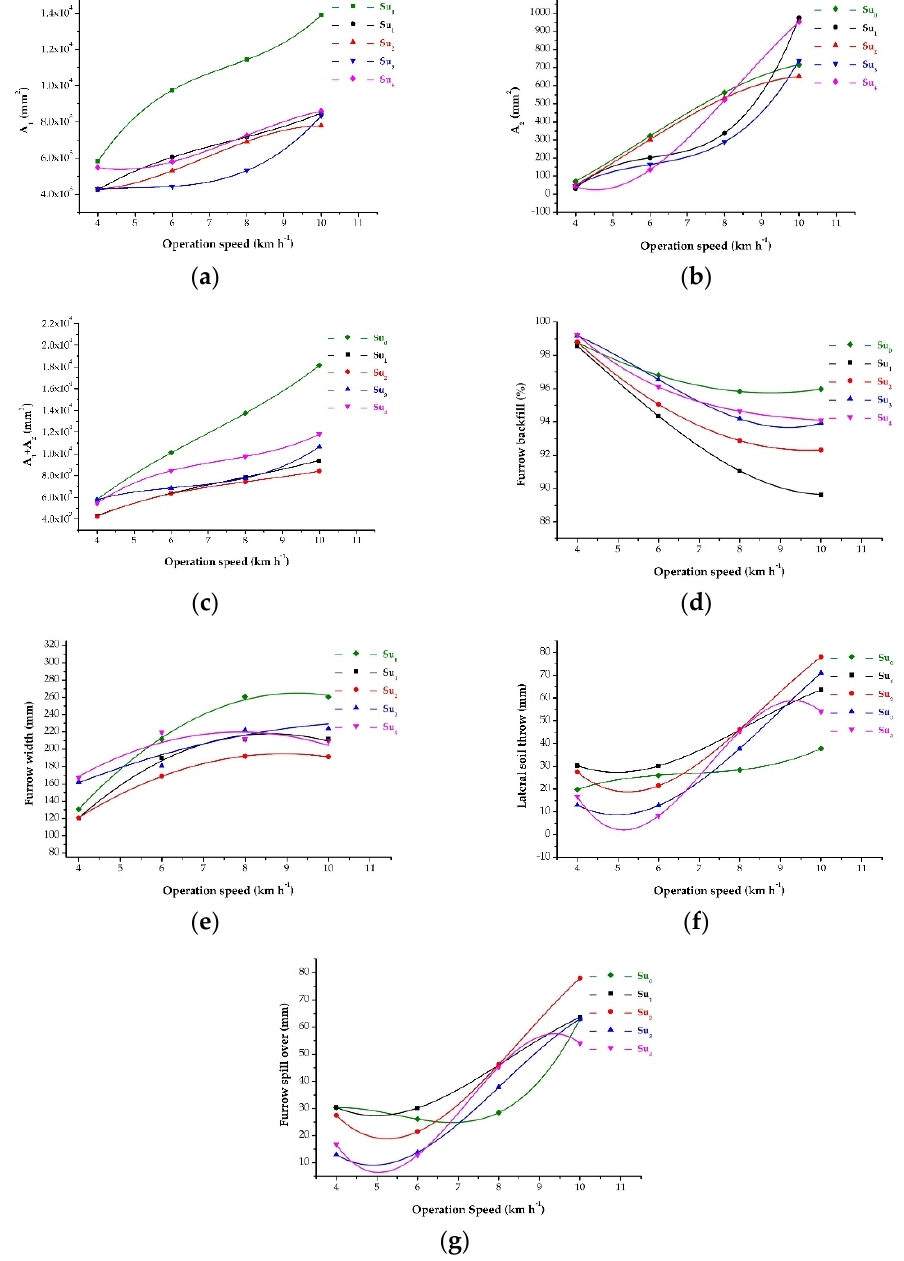
Figure 15. Main parameters of furrow profile predicted by discrete element test: ( a ) A 1 ; ( b )A 2 ; ( c ) A 1 + A 2 ; ( d ) Furrow backfill; ( e ) Furrow width; ( f ) Lateral soil throw; ( g ) Furrow spill over.